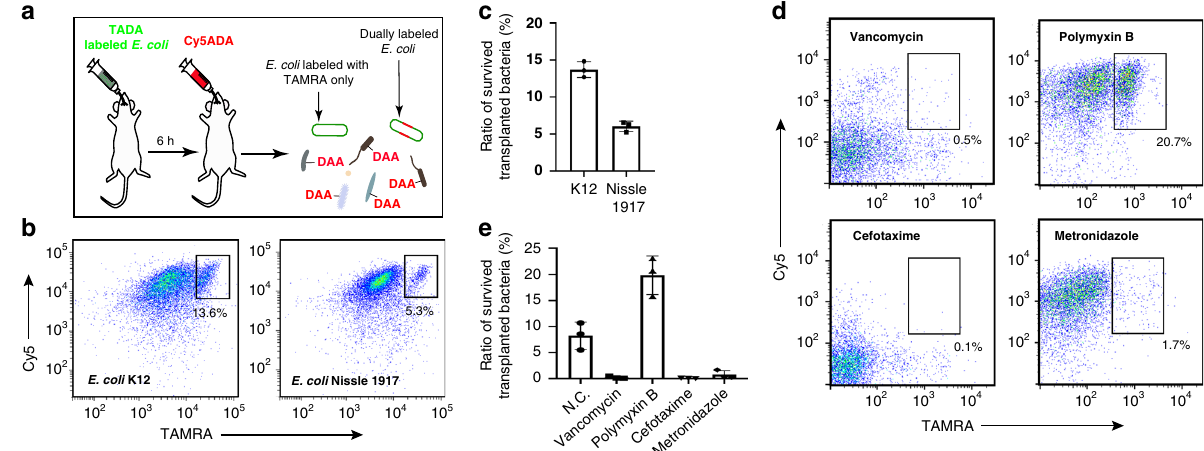
Fig. 4 Evaluation of the survival of speci fi c bacteria, and the antibiotic preconditioning effects. a Schematic showing the experimental procedures for assessing the viability of E. coli during transplantation using STAMP. b Flow cytometry analysis of the transplanted E. coli strains K12 (left) and Nissle 1917 (right). The inserted numbers indicate the survival rates. c Statistical analysis of the survival rates of transplanted E. coli K12 and Nissle 1917. Mean± s.d. are presented for n = 3. d Flow cytometry analysis of the STAMP-labeled gut microbiota from recipient mice with preconditioning of vancomycin, polymyxin B, cefotaxime, or metronidazole. The inserted numbers indicate the survival rates. e Statistical analysis of the survival rates of the transplanted microbiotas from recipient mice with antibiotic preconditioning. Mean ± s.d. are presented for n = 3 NATURE COMMUNICATIONS| (2019) 10:1317